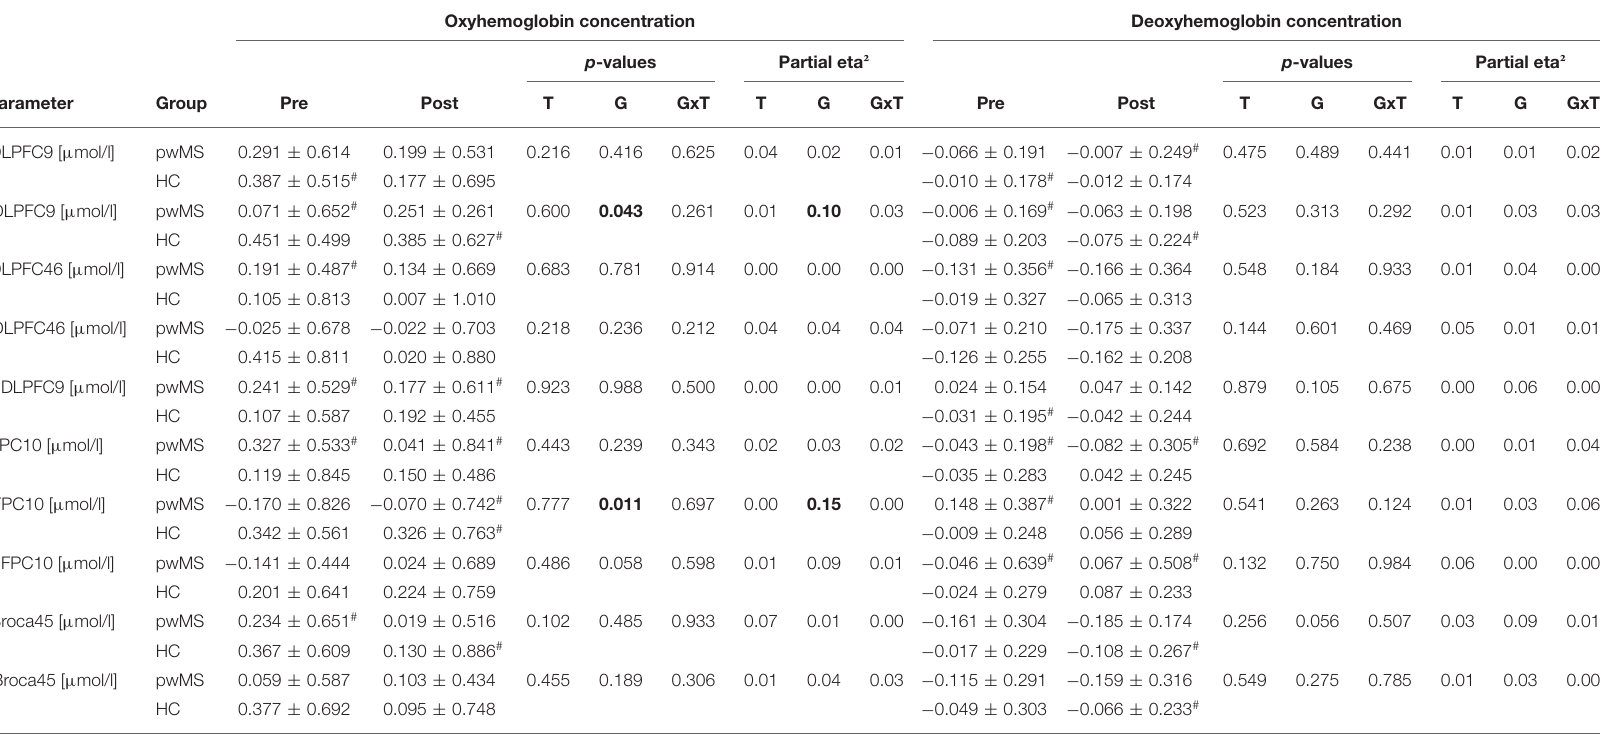
TABLE 2 | Oxy-/deoxyhemoglobin concentrations in the subareas of the prefrontal cortex recorded during dual-task walking before and after the fast 6MWT (mean ± standard deviation) and rmANOVA outcomes ( p -values and effect size partial eta ²